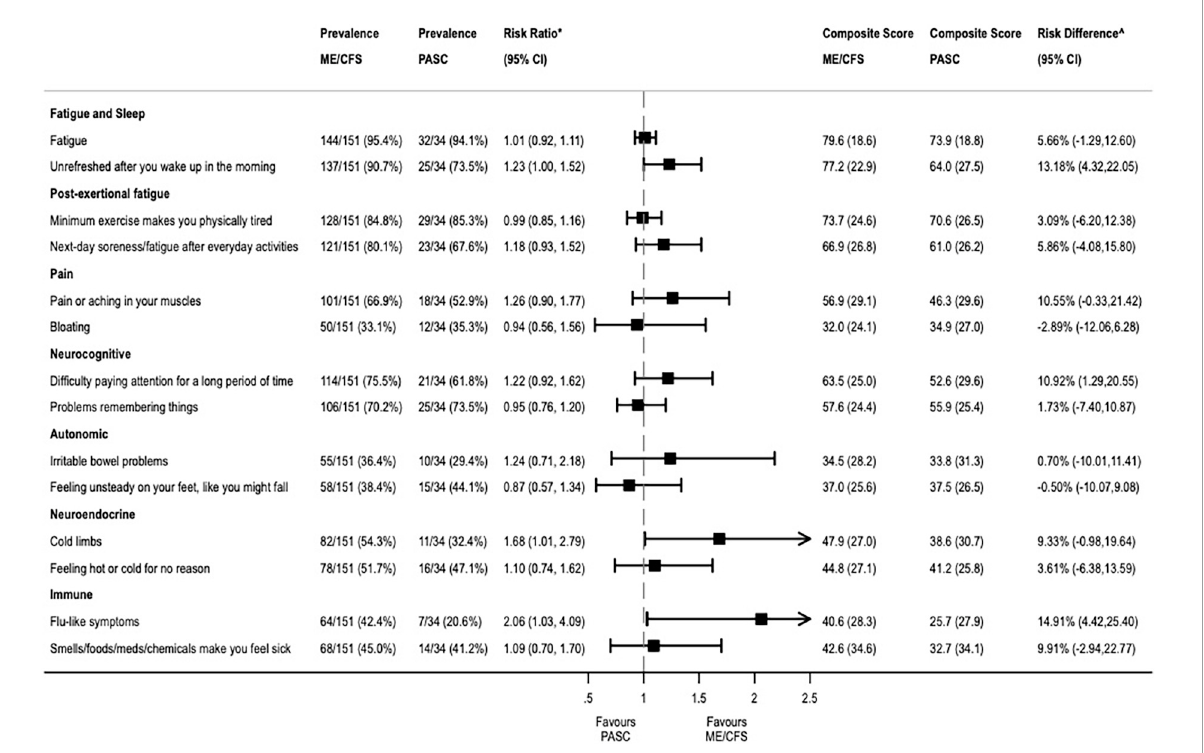
Supplementary Figure 1 . Mean composite symptom